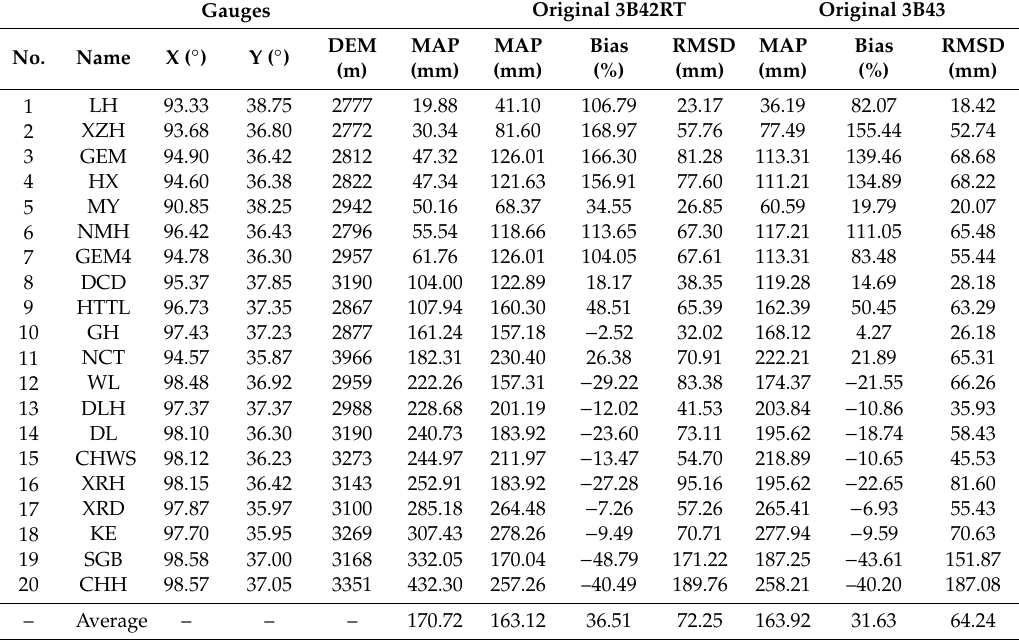
Table 1. The precision of original Tropical Precipitation Measurement Satellite (TRMM) products